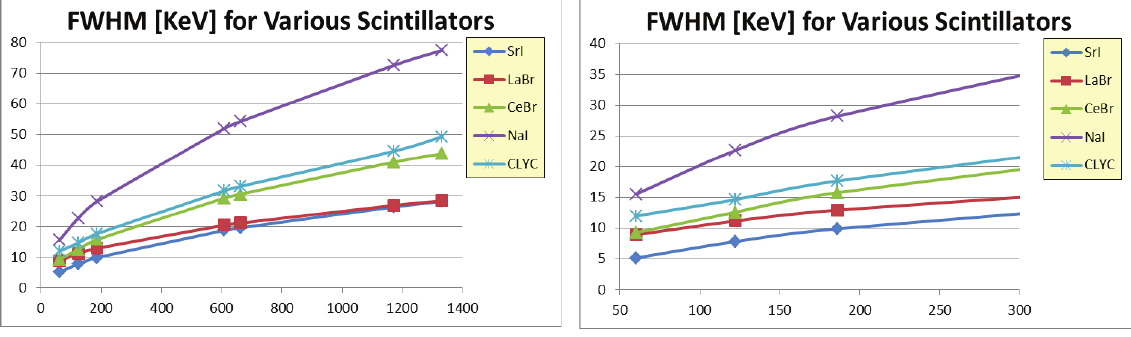
Figure 10 FWHM in keV for various scintillators as a function of gamma energy. The graph on the right is a expanded view of the graphs on the left.